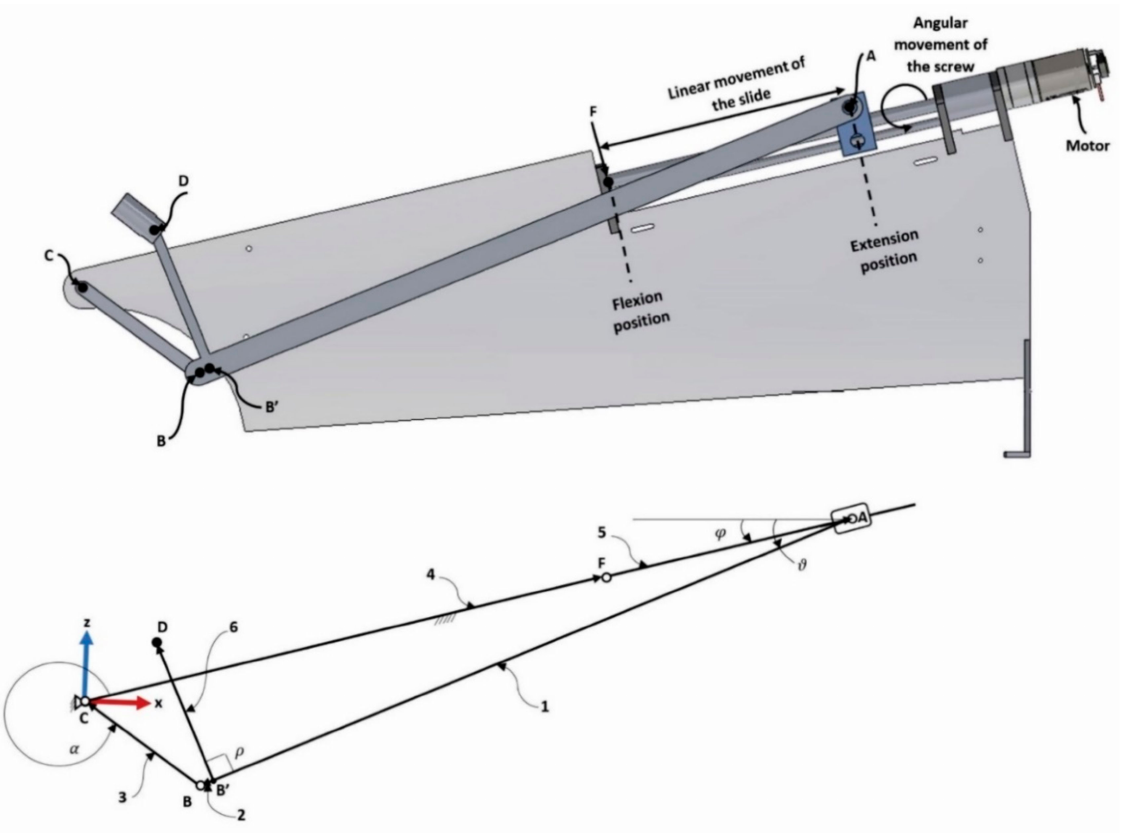
Figure 6. CAD (computer-aided design) and vector representation of the existing